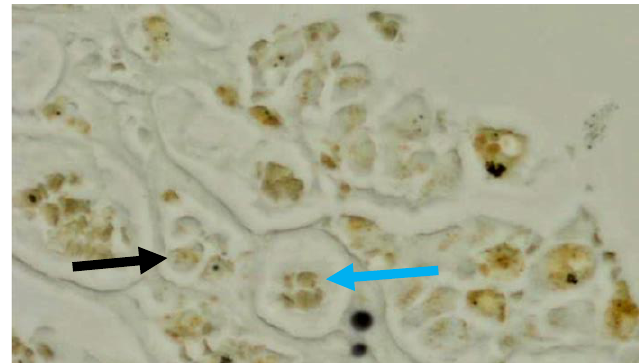
Figure 3. Histochemical section of medulla of squirrel adrenal gland showing a noradrenaline cells (blue arrow) and adrenaline cells (black arrow). Potassium dichromate salts. H&E,1000×